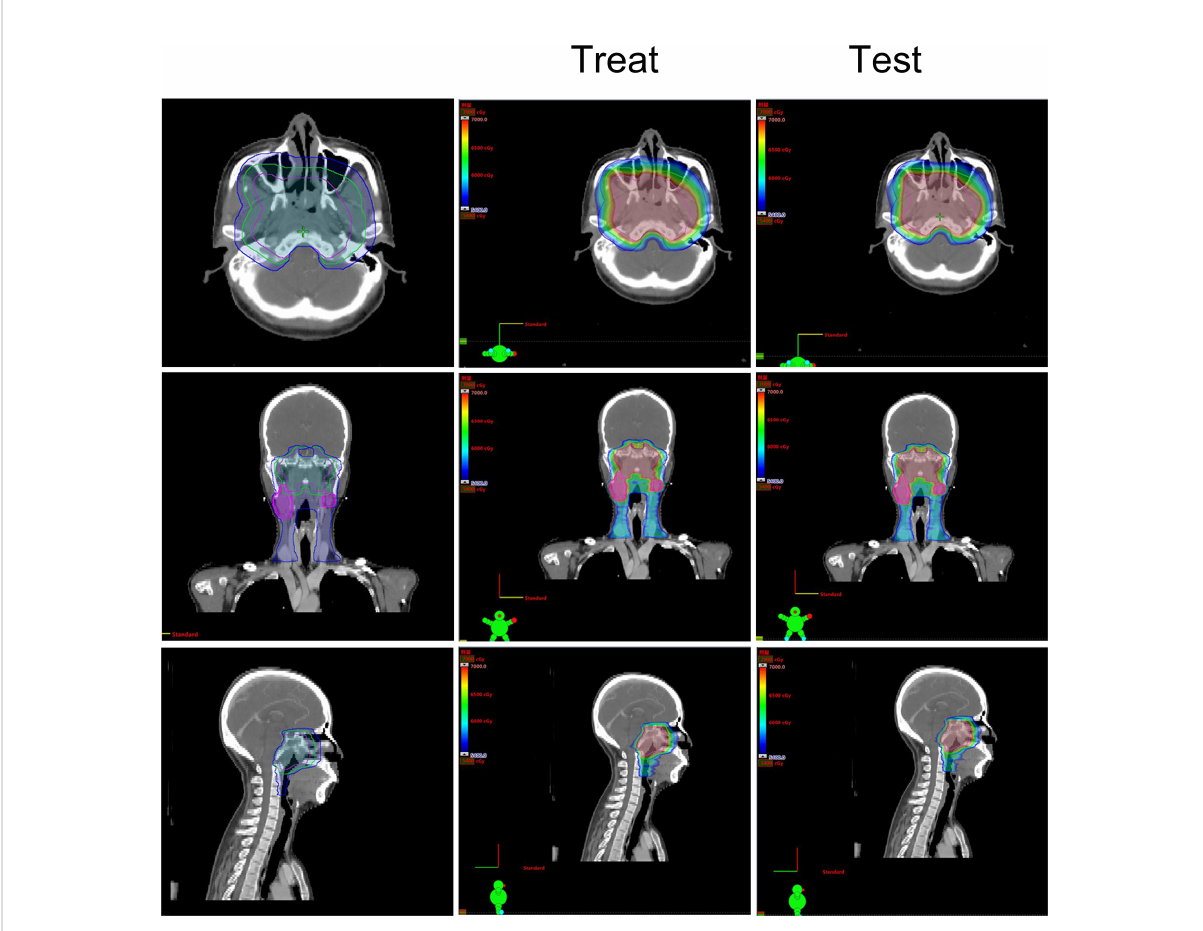
FIGURE 1 The treatment target area and dose distribution of a T4 nasopharyngeal carcinoma patient. Left: The treatment target area diagram; Middle: The dose distribution diagram of treat-plan; Right: The dose distribution diagram of test-plan.